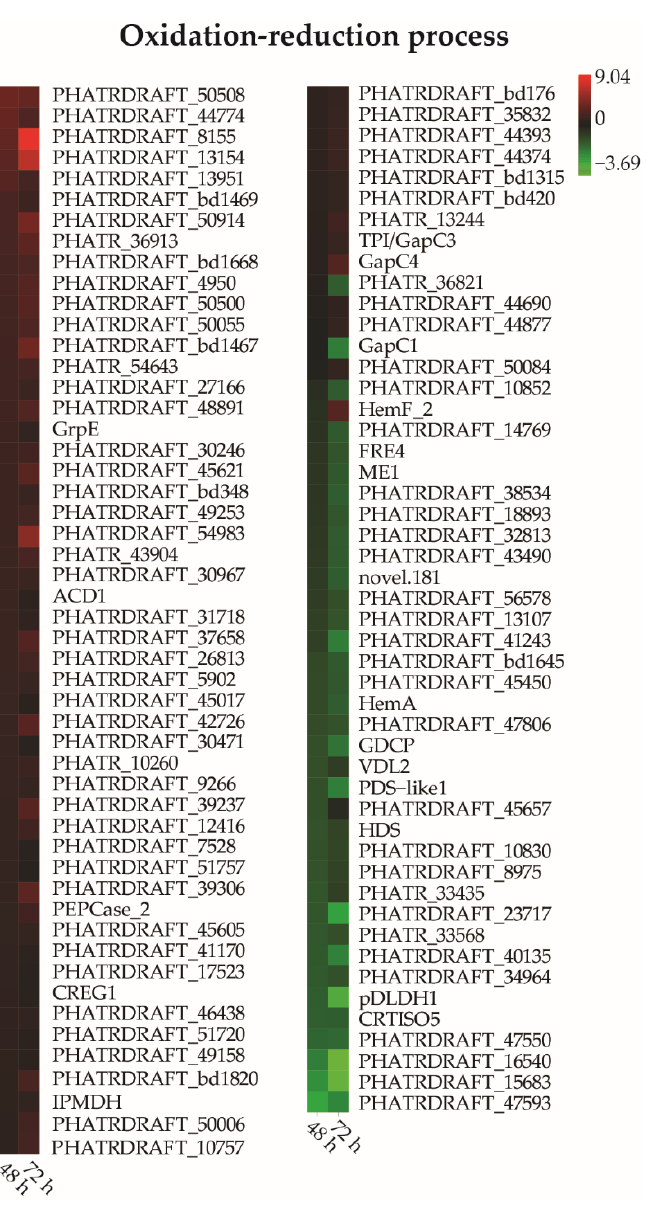
Figure 6. Heatmap of differentially expressed genes involved in oxidation-reduction processes that responded to exposure to mixtures of BDE-47 and nickel. Only genes with |log2 fold| changes > 2 and p < 0.05 after 48 h and/or 72 h are